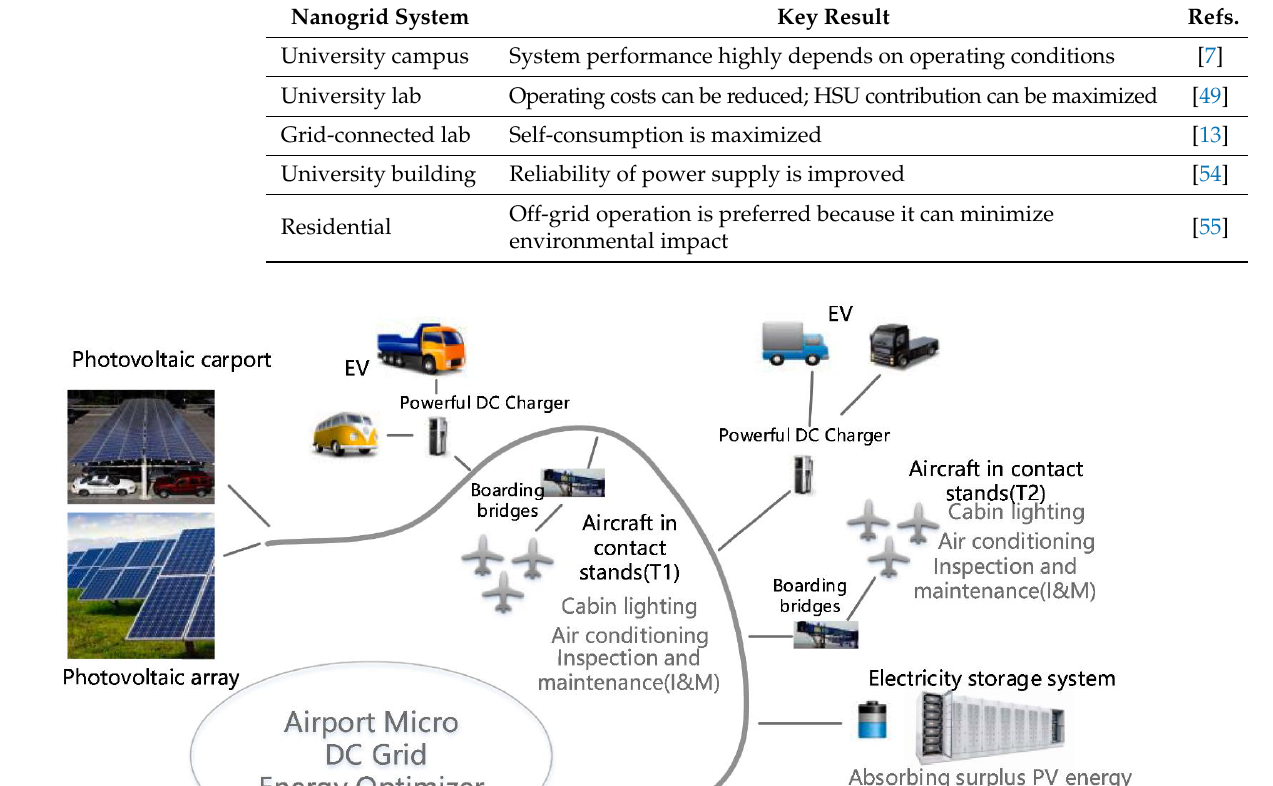
Table 3. Nanogrid system applications.